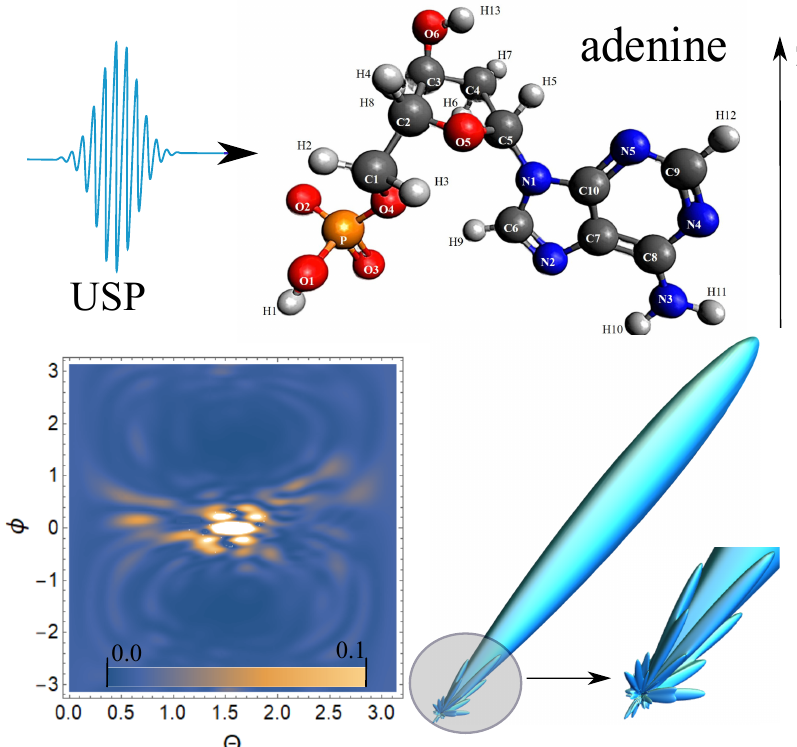
Figure 2. The spectra of USP scattering on adenine are presented. The direction of incidence of the USP corresponds to the representation in the figure and is perpendicular to the z axis. A contour plot of the normalized scattering spectrum is shown on the bottom left, and a 3D spatial scattering spectrum with a clipping from the region where the scattering is most diverse is shown on the bottom